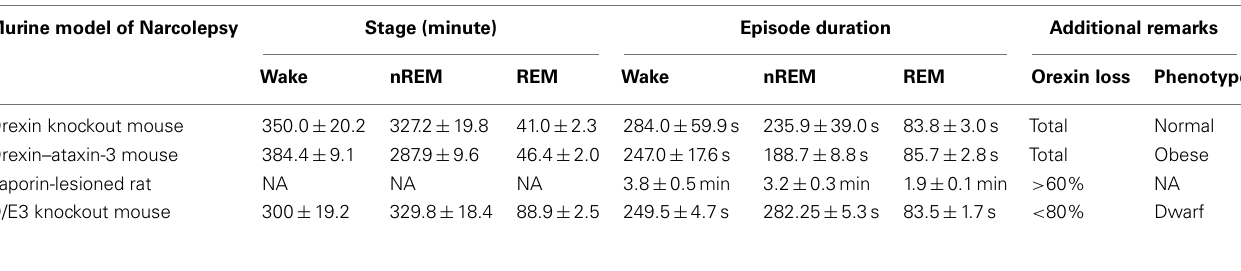
Table 1 | Time during the dark